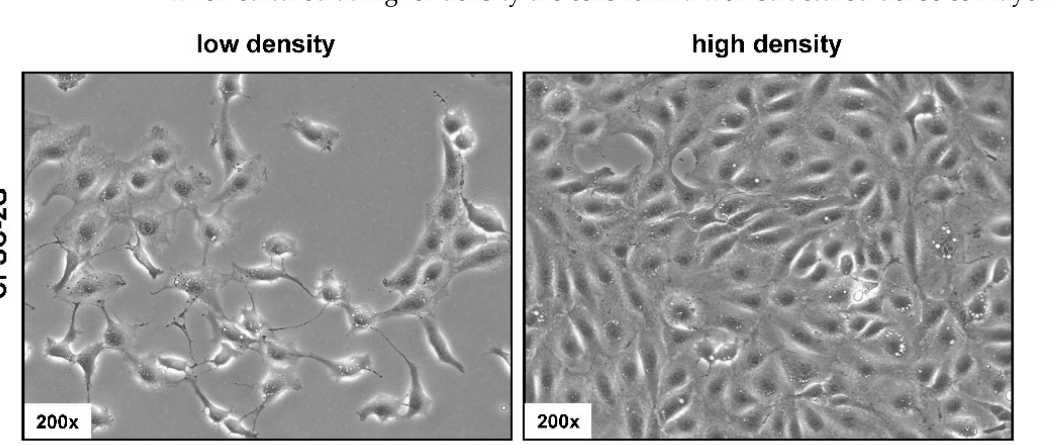
Figure 3. Light microscopic appearance of CFSC-2G cells. Cells were seeded in cell culture dishes and representative images taken at different cell densities at magnifications of 200×. Please note the extensive protrusions of the cells when cultured at low density.